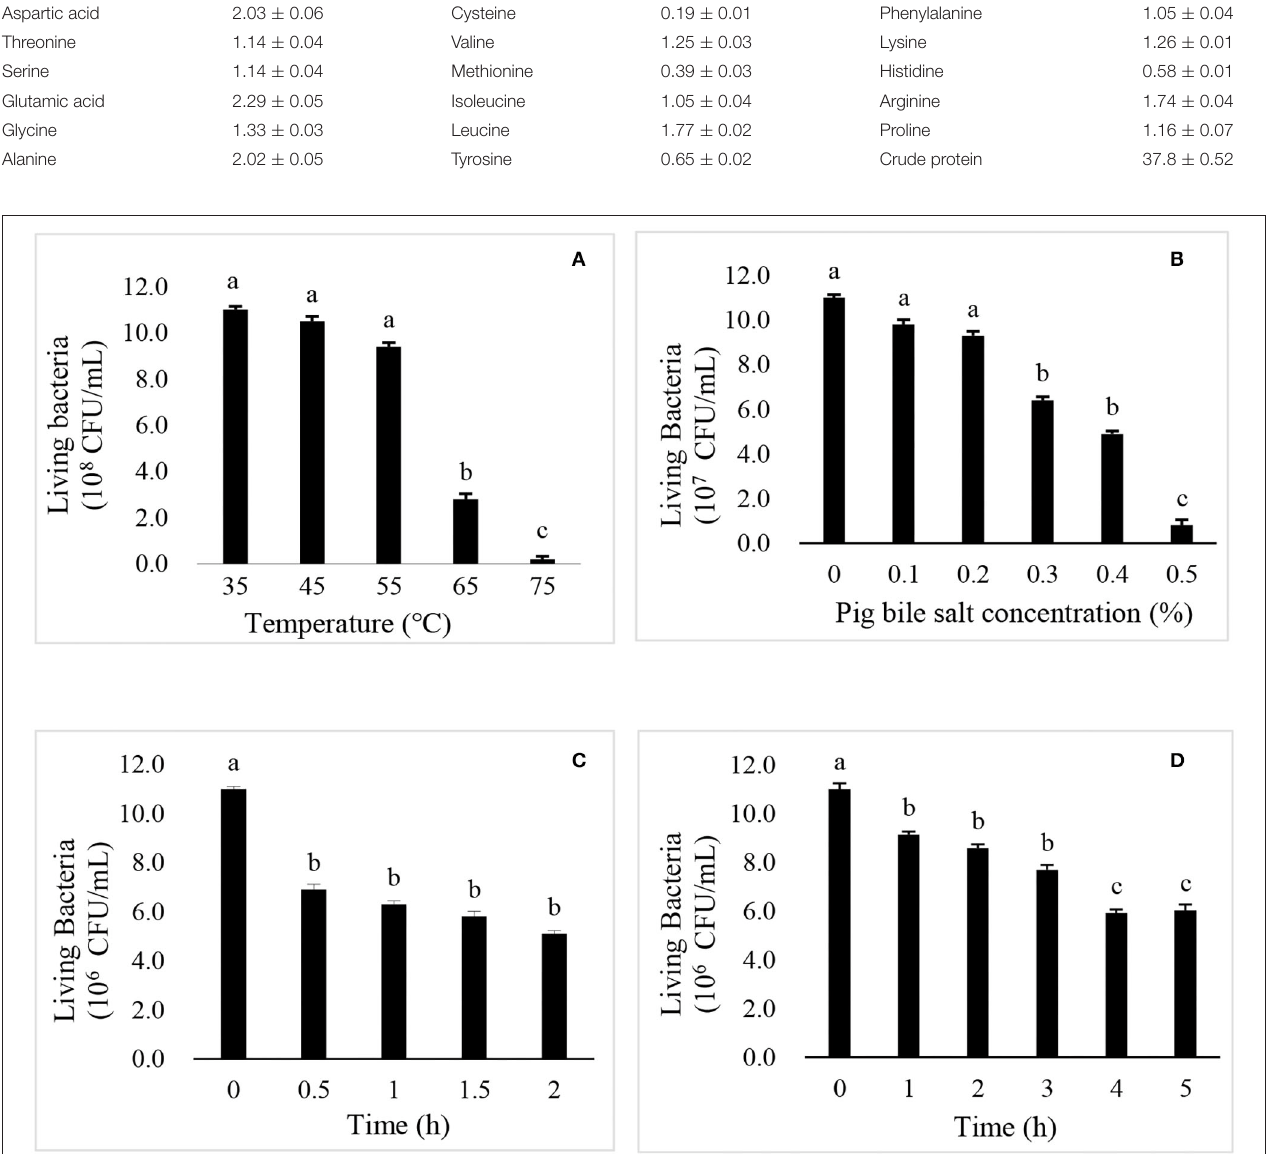
mucilaginosa TZR 2014 in the medium with 0.3% and 0.4% pig bile salt decreased ( P < 0.05). R. mucilaginosa TZR 2014 in medium with more than 0.5% pig bile salt hardly